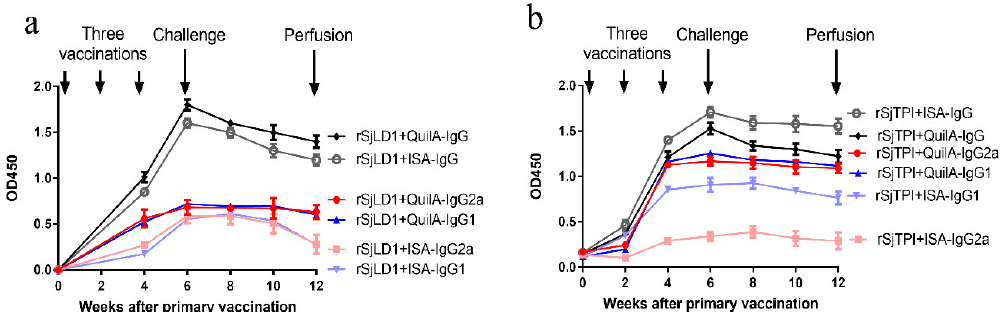
Figure 1. Kinetics of specific IgG and IgG1 and IgG2a antibody isotypes induced in mice immunised with the rSjLD1 and rSjTPI vaccine, respectively, conjugated with QuilA or ISA720. ( a ) Anti-rSjLD1 specific IgG, IgG1 and IgG2a antibody isotype levels (OD450) in mice vaccinated with rSjLD1 + QuilA or rSjLD1 + ISA and ( b ) Anti-rSjTPI specific IgG, IgG1 and IgG2a antibody isotype levels in mice vaccinated with rSjTPI + QuilA or rSjTPI + ISA are shown over the 12 weeks after the primary vaccination and include time points at week 0, weeks 2 and 4 after the primary vaccination (2 boosts), week 6 (just prior to challenge with S. japonicum cercariae) and week 12 (just prior to perfusion).